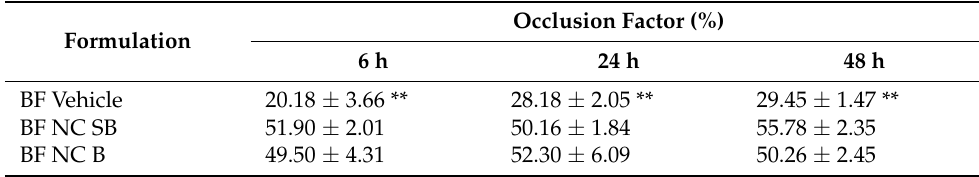
Table 2. Occlusion factor of bilayer